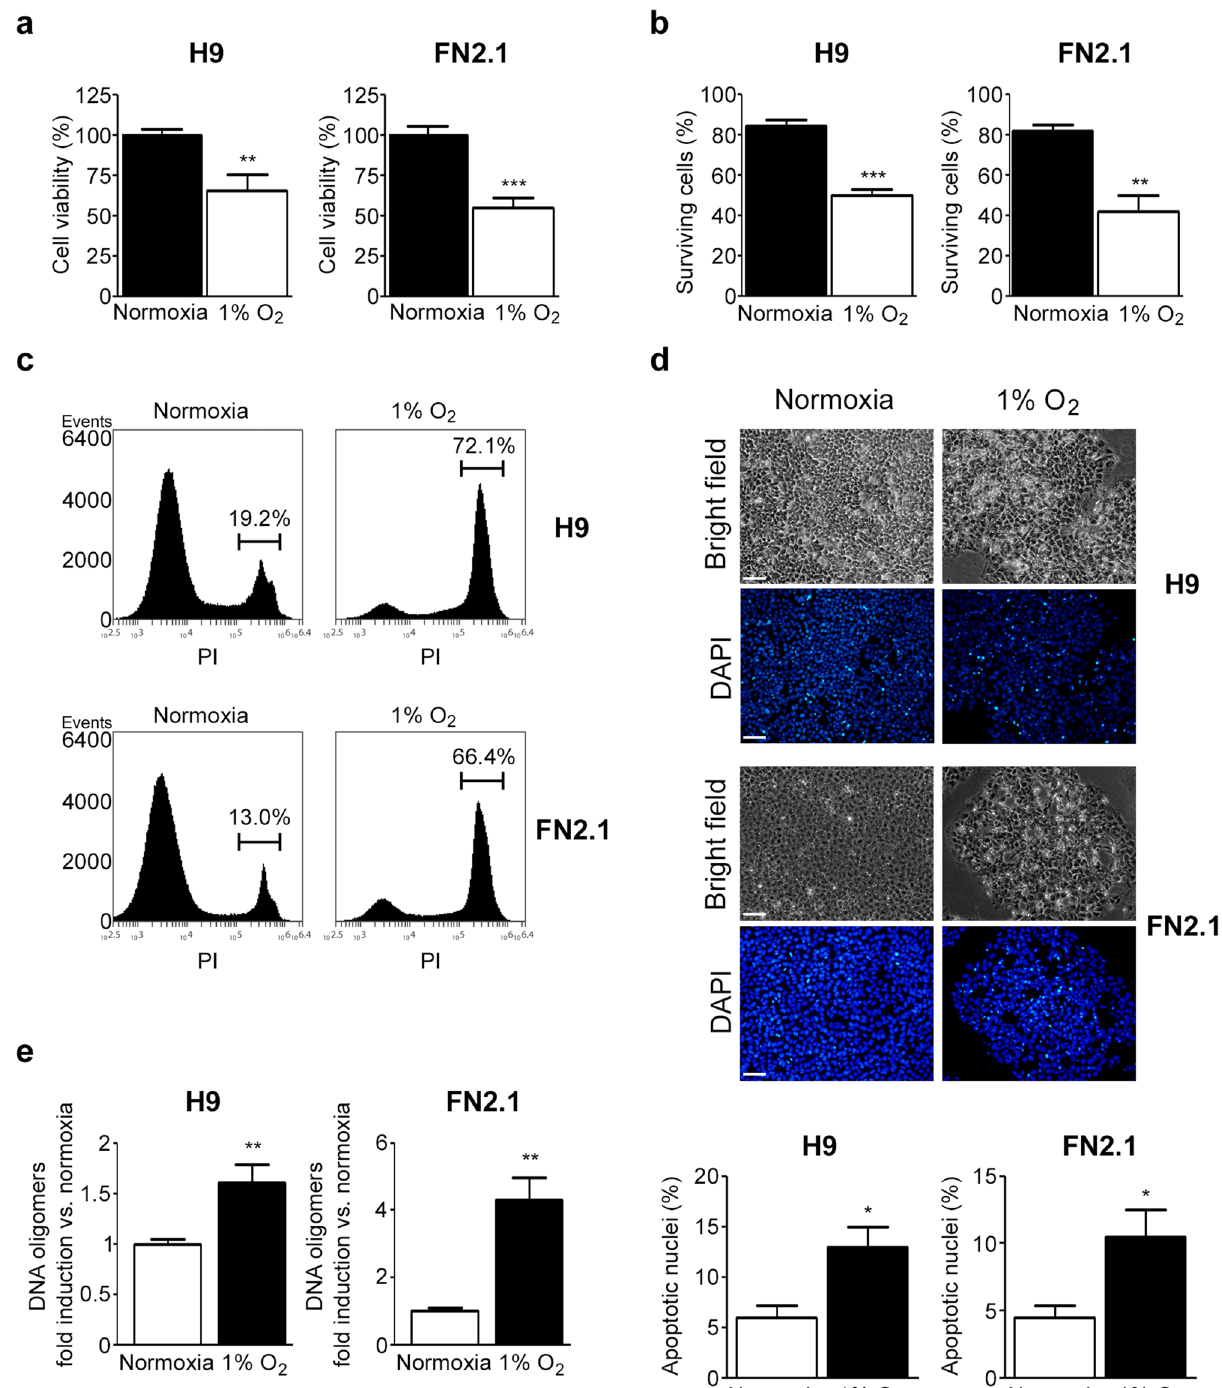
Figure 2. Changes in cell viability and cell death induced by 1% O 2 treatment in hPSCs. ( a ) H9 and FN2.1 cell viability was analyzed 24 h post 1% O 2 treatment by XTT colorimetric assay. Mean + SEM from three independent experiments are shown. Statistical analysis was done by Student’s t-test, (**) p < 0.01 and (***) p < 0.001 versus normoxia. ( b ) Bar graphs show the percentage of surviving cells assessed by Trypan blue exclusion method 24 h after 1% O 2 incubation. Mean + SEM from at least three independent experiments are shown. Statistical analysis was done by Student’s t-test, (**) p < 0.01 and (***) p < 0.001 versus normoxia. ( c ) Representative histograms of three independent experiments of Propidium iodide (PI) stained H9 and FN2.1 unfixed cells treated for 24 h with 1% O 2 . The percentage of PI-positive cells (late apoptotic or necrotic) was determined by flow cytometric analysis. ( d ) Chromatin condensation was analyzed by DAPI staining 24 h after 1% O 2 . Figure shows representative images and means + SEM from three independent experiments is graphed for % of apoptotic nuclei. The scale bar represents 100 μm. Statistical analysis was done by one-way ANOVAs followed by Student’s t-test, (*) p < 0.05 vs. normoxia. ( e ) Genomic DNA fragmentation into oligomers of 180–200 bp or multiples of that was quantified in H9 and FN2.1 cells at 24 h post 1% O 2 hypoxia induction using a specific ELISA kit. Mean + SEM fold induction relative to normoxia of three independent experiments is shown. Statistical analysis was done by Student’s t-test, (**) p < 0.01 versus